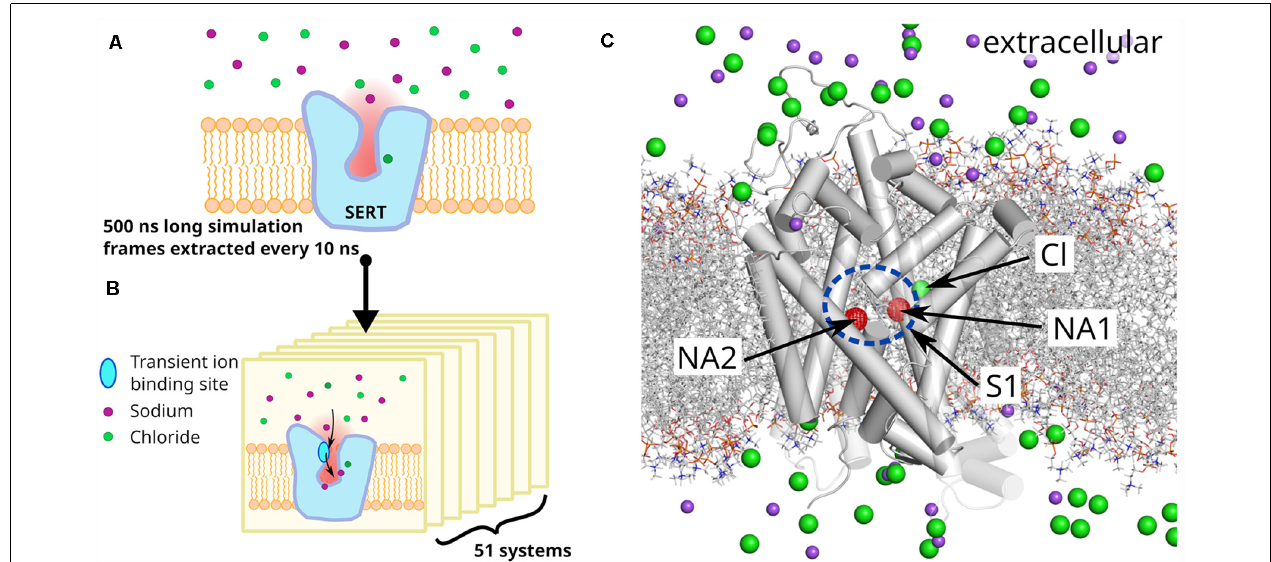
FIGURE 1 | System and system setup. (A) A 500 ns long unbiased simulation of serotonin transporter (SERT) in the absence of bound sodium ions was carried out to prepare a set of starting systems. (B) Fifty-one snapshots separated by 10 ns were extracted and sodium ions removed, if present in the outer vestibule. All systems were independently simulated for 150 ns. (C) Representative starting structure of a selected SERT snapshot, showing sodium (purple) and chloride (green) ions as spheres and highlighting the sodium binding sites NA1 and NA2 by red spheres. The substrate binding site S1 is indicated by a blue ellipse. The lipid membrane is represented by gray dashed lines. NA1 is formed by TM1, TM6 and TM7, NA2 by TM1 and TM8. Temporary binding sites are formed by D326, E493, and E494 from which E493 is part of the extracellular gate (EC) with